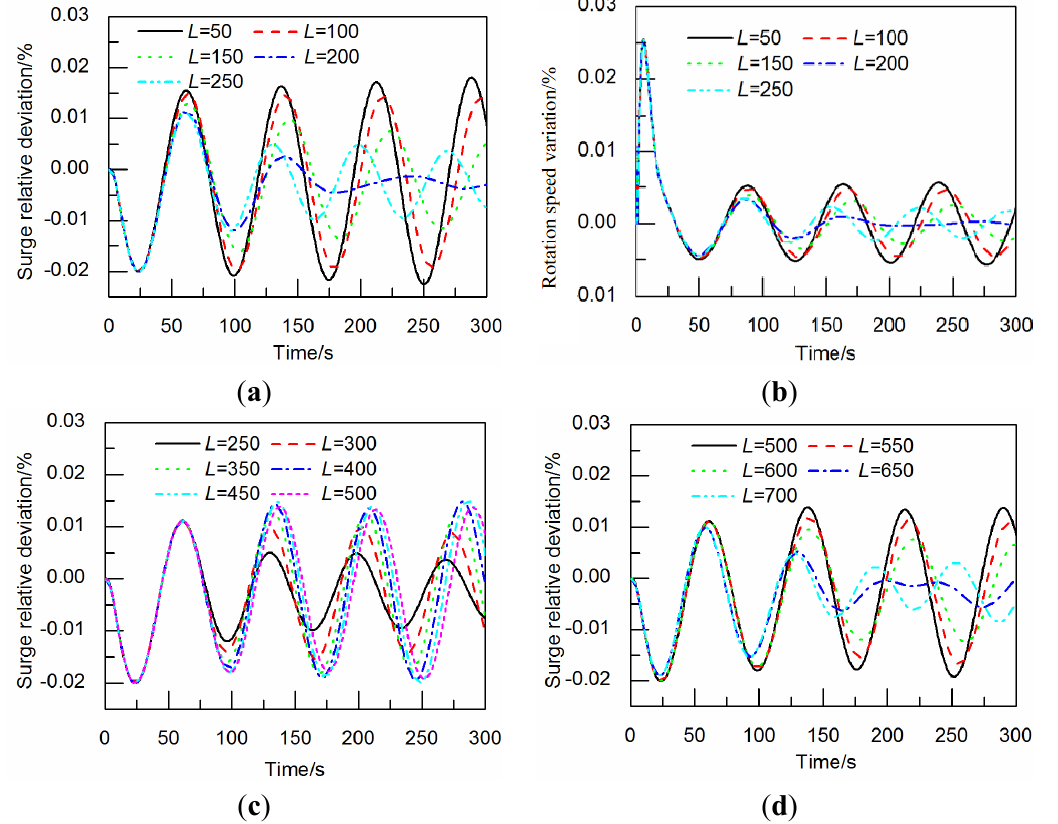
Figure 8. The influence of an open channel length (m) on surge and rotation speed: ( a ) surge variation, when open channel length ( L ) is ranged between 50 m and 250 m; ( b ) rotation speed variation, when open channel ( L ) is ranged between 50 m and 250 m; ( c ) surge variation, when open channel length ( L ) is ranged between 250 m and 500 m; ( d ) surge variation, when open channel ( L ) is ranged between 500 m and 700 m.